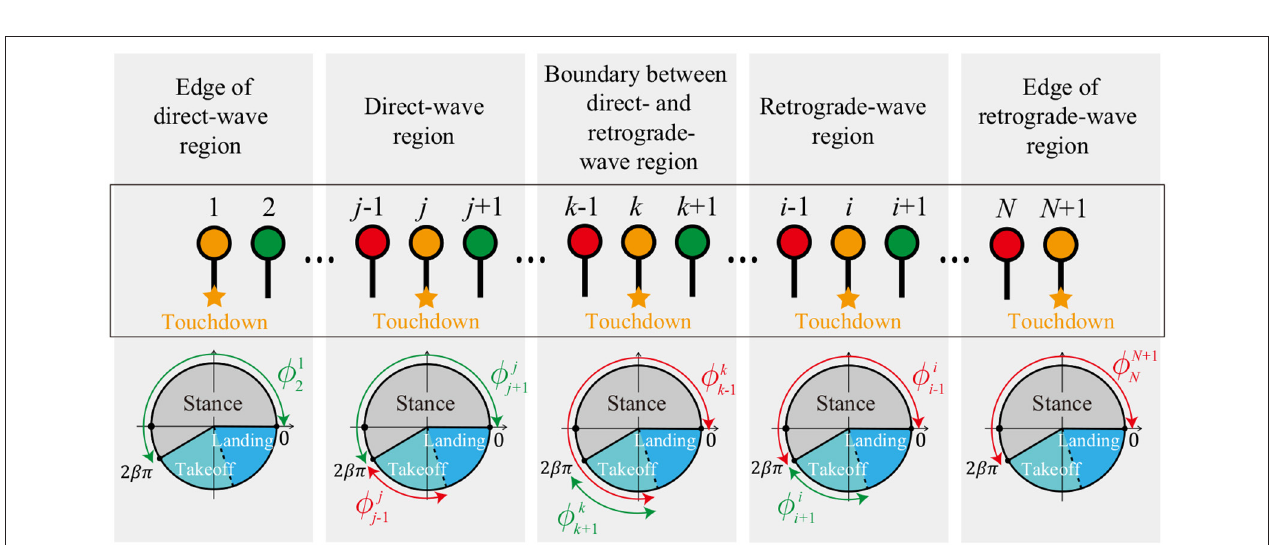
1, k [2, N ]) propagate anteriorly, − ∈